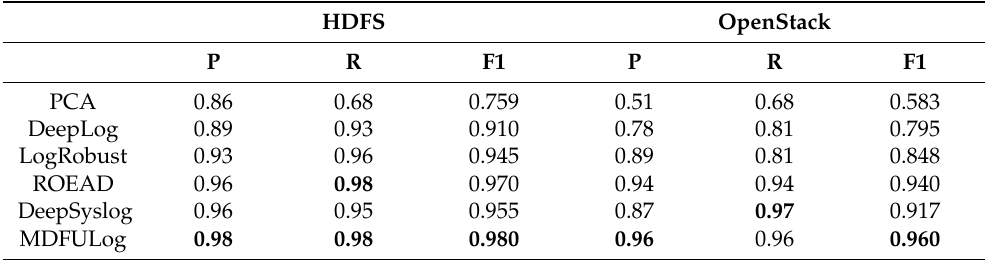
Table 1. Results of comparing MDFULog with the baseline methods on stable datasets.